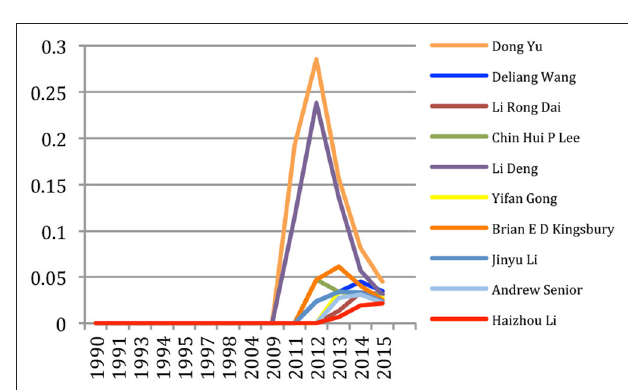
FIGURE 14 | Main contribution areas for H. Ney (% of topical papers).